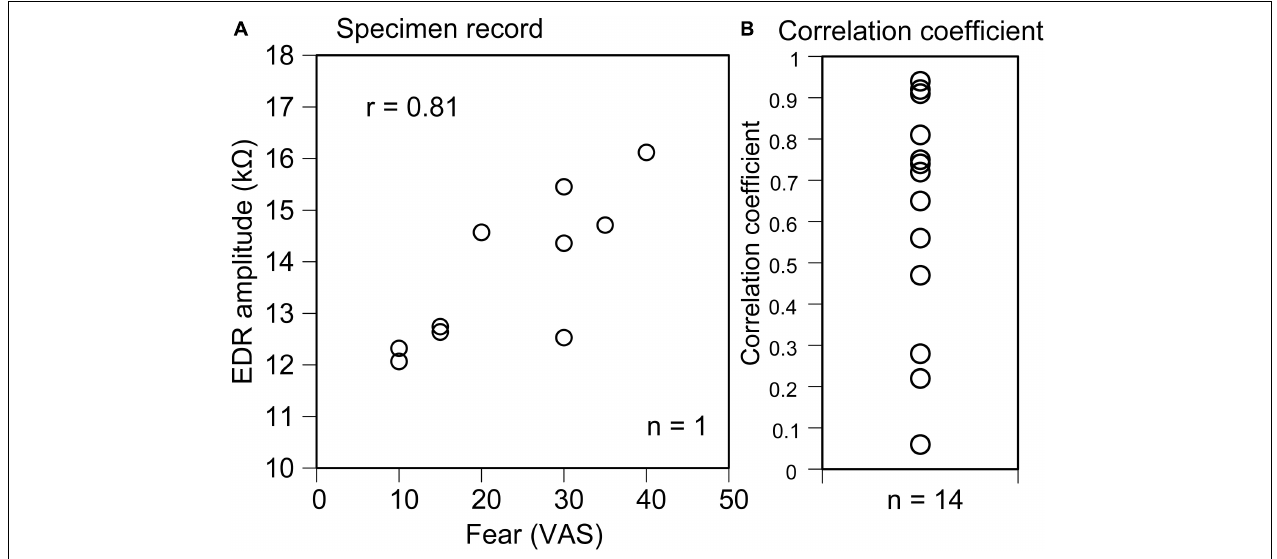
FIGURE 2 | Scatter plot of the EDR amplitude as the function of the VAS indicating fear in a participant (A) and plot of the correlation coefficient between the EDR amplitude and VAS indicating fear across the participants (B) . TABLE 3 | Effect of time prediction.